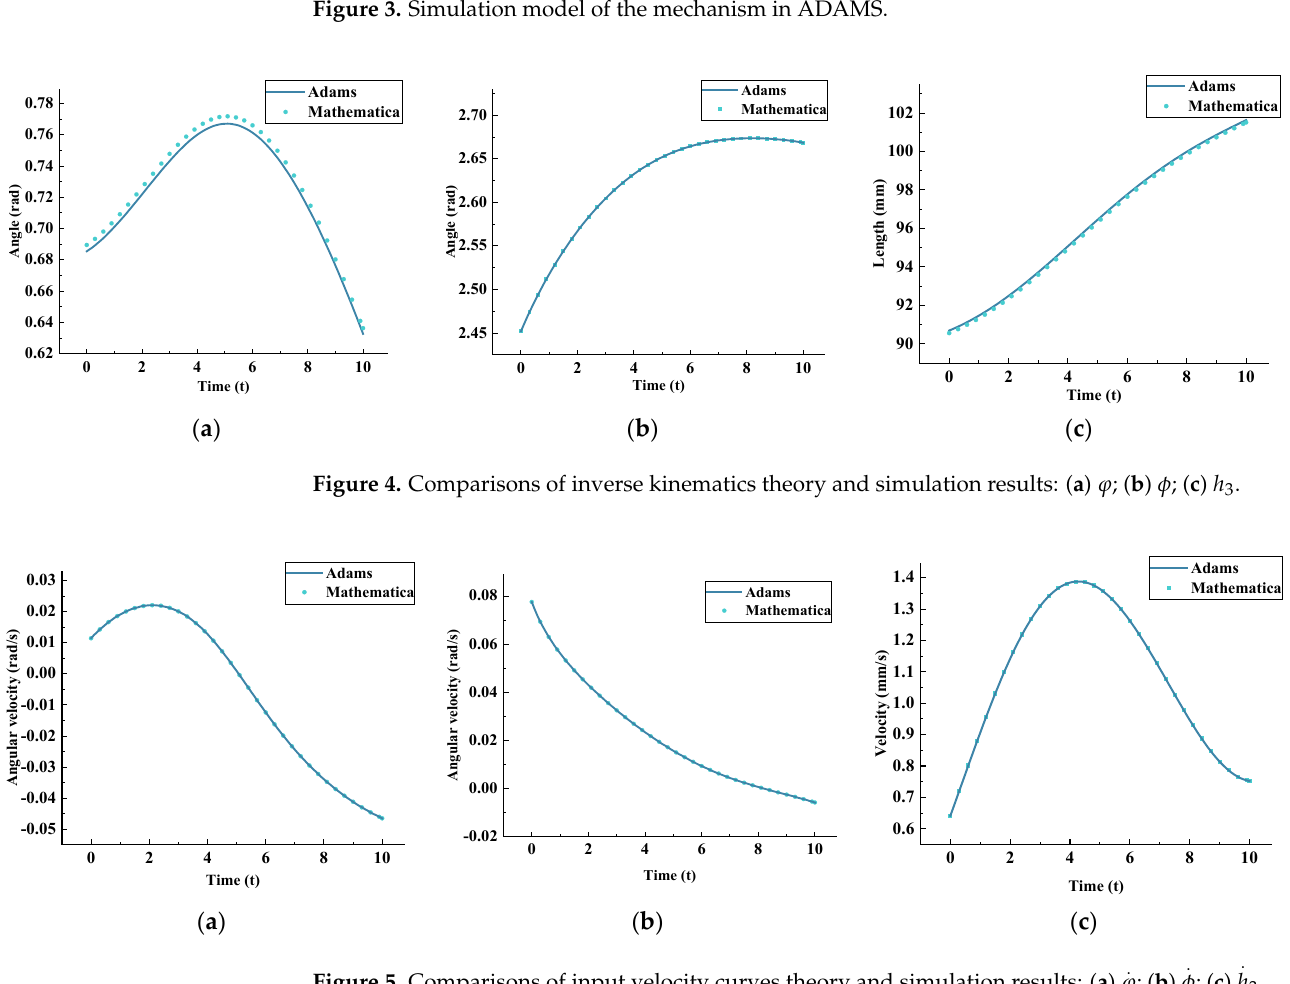
Figure 5. Comparisons of input velocity curves theory and simulation results: ( a ) ϕ ; ( b ) φ